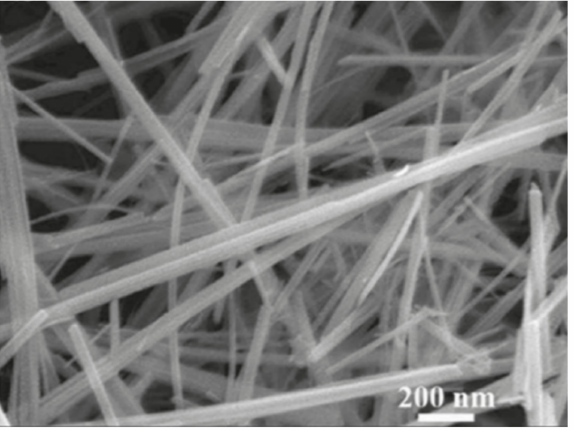
Figure 7. SEM image of α -MnO 2 nanowires. Reprinted with permission from [19]. Copyright 2010 American Chemical Society.